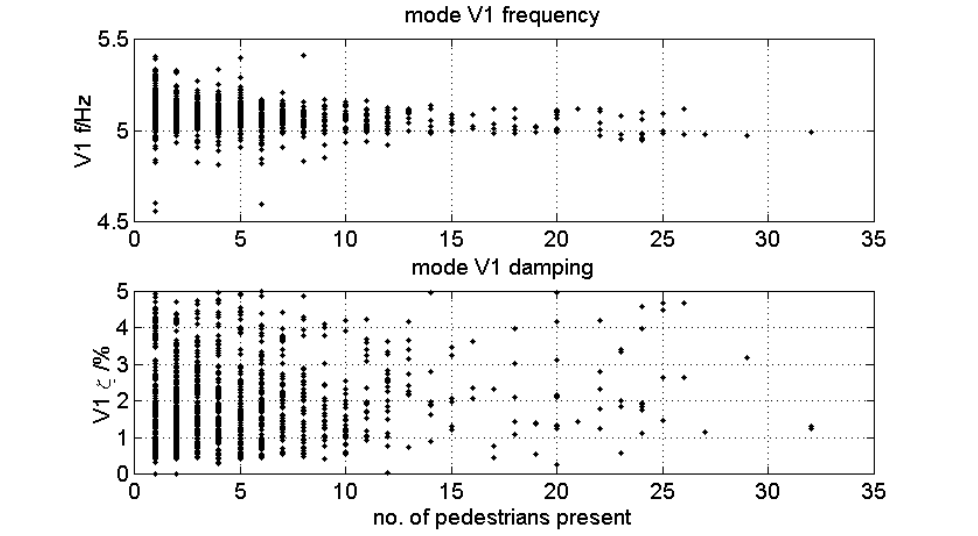
Fig. 12. Estimates of vertical mode frequency and damping with pedestrians walking across